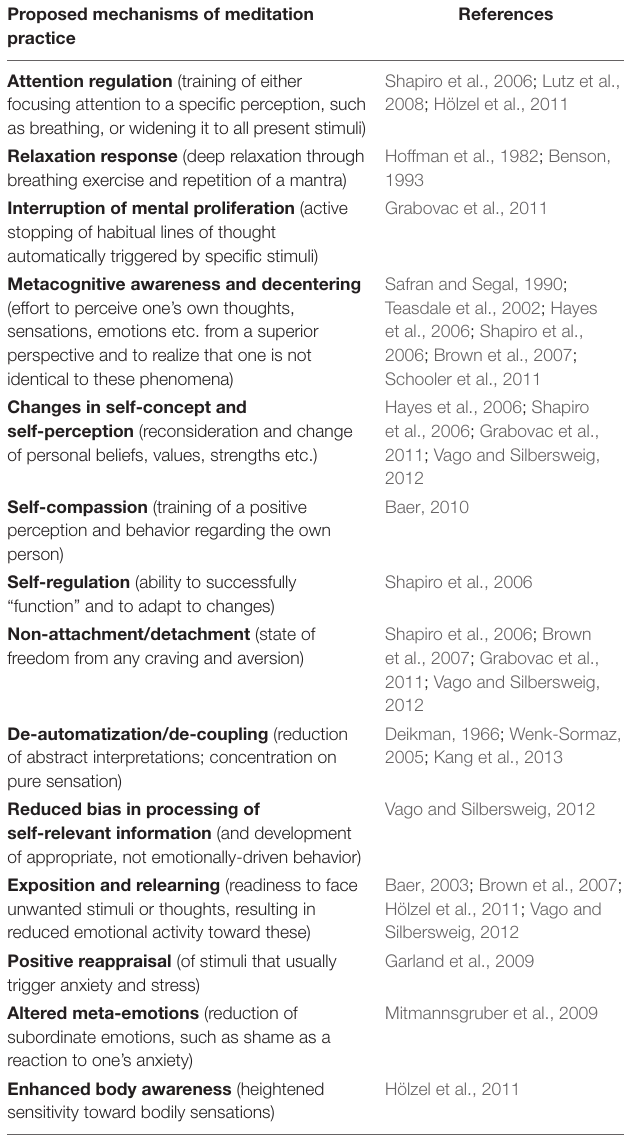
TABLE 1 | Proposed mechanisms in the Western literature of how meditation leads to its positive effects. Proposed mechanisms of meditation